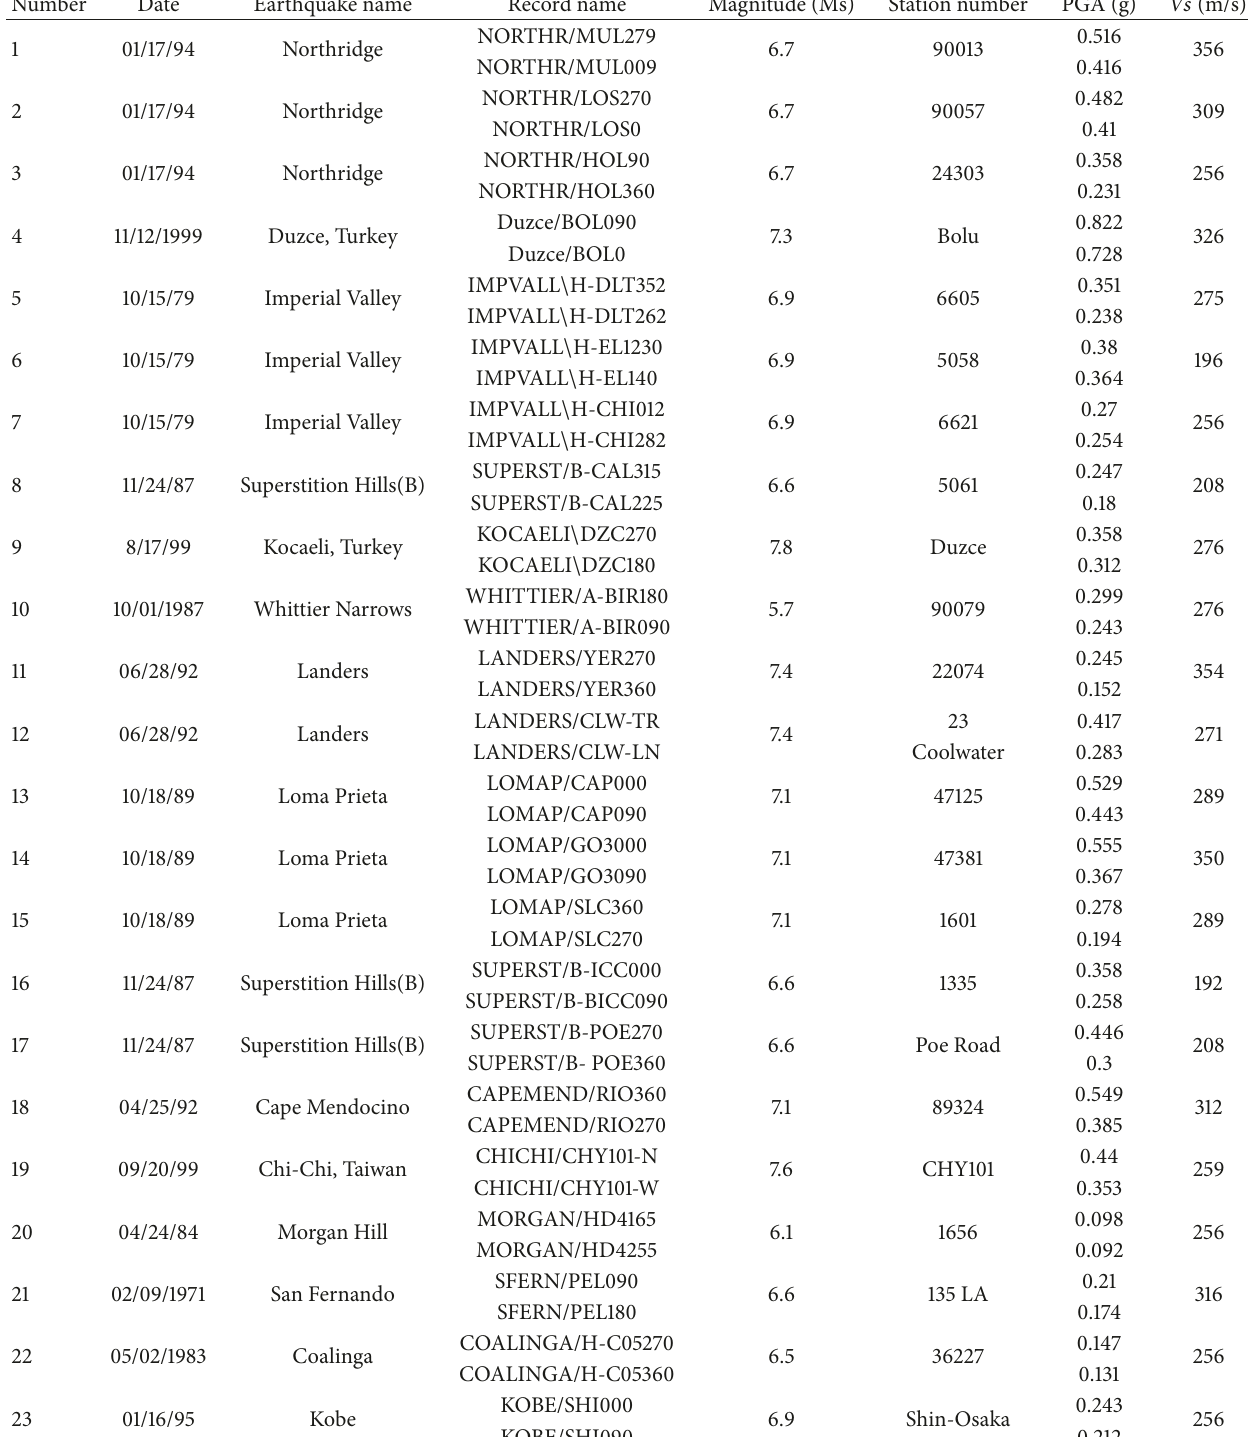
Table 4: Characteristics of 23 pairs of far field earthquake records for the numerical